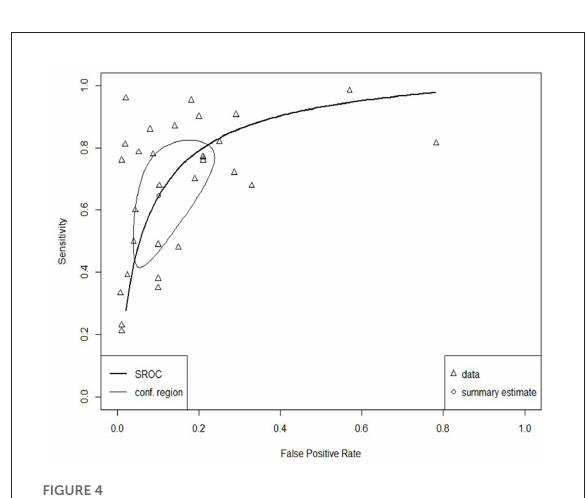
FIGURE4 SROC curve for all studies ( n = 31).